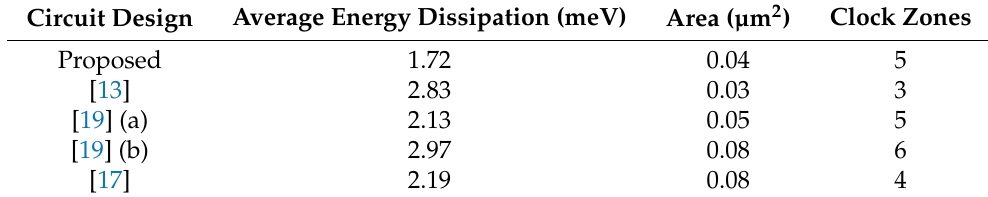
Table 5. Comparison of proposed 4 × 1 MUX with existing